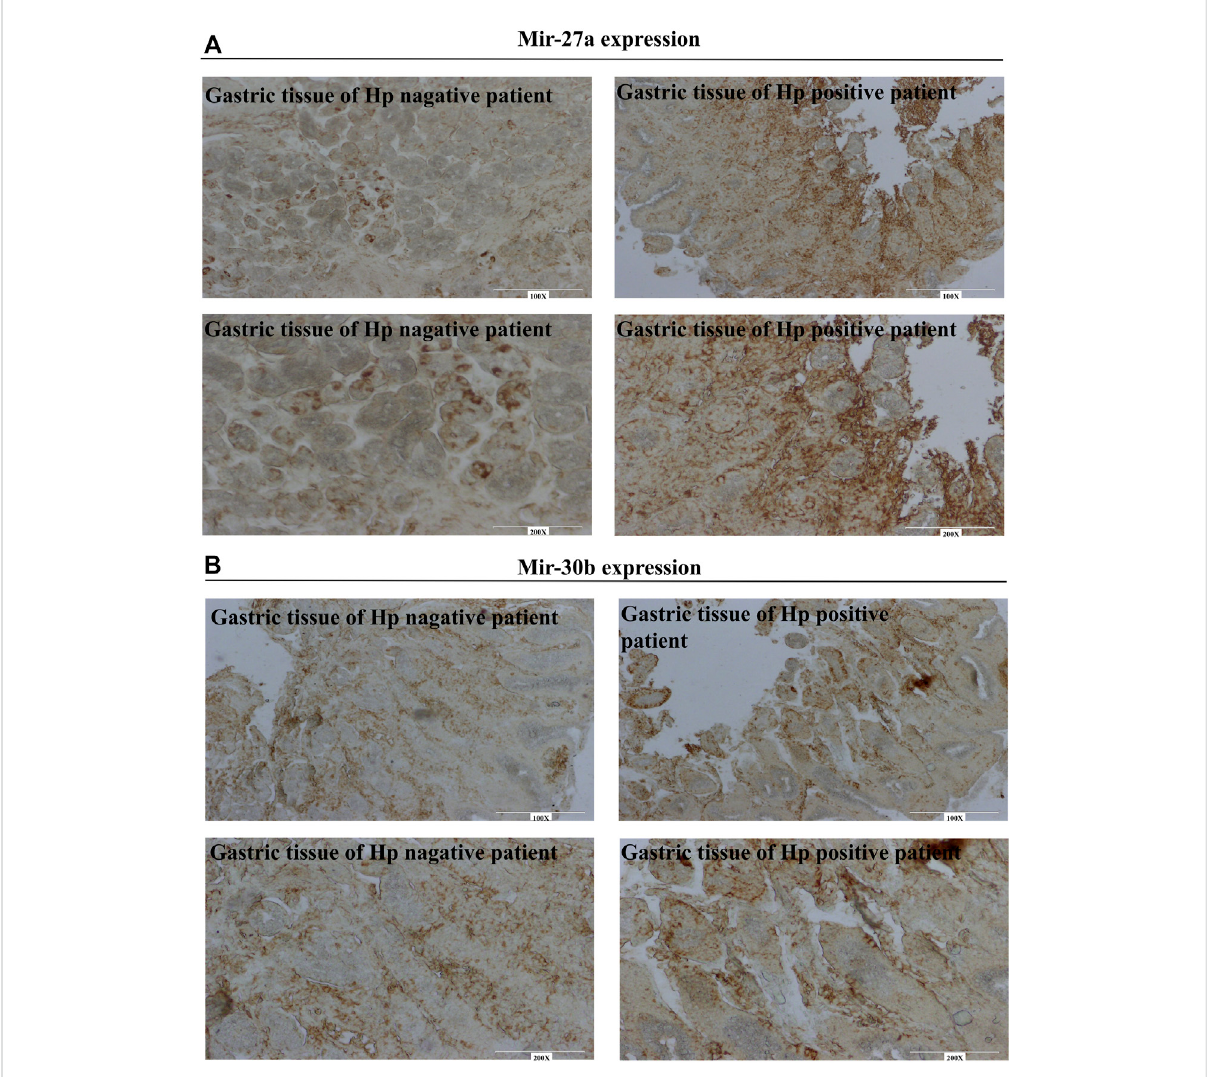
FIGURE 3 Identifying ofmiR-27aandmiR-30bingastroofpatientsusing insitu hybridization. (A) MiR-27aexpressioningastroofHpnegativeandpositive patients. (B) MiR-30b expression in gastro of Hp negative and positive